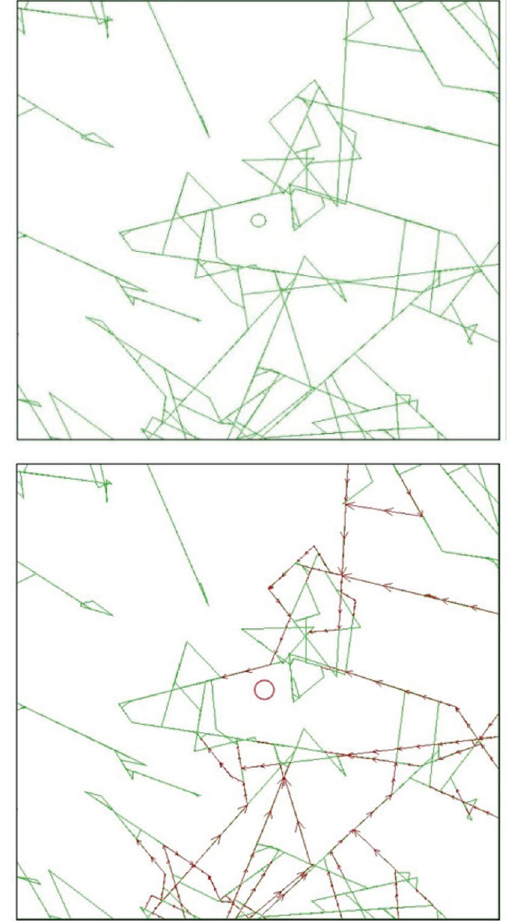
Fig. 8 Location of fractures and currents around them